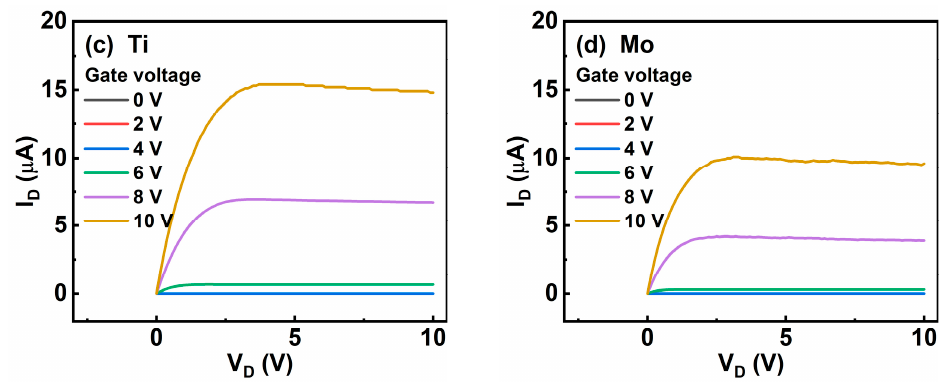
Figure 4. Output curves of annealed ITO TFTs with ( a ) Al, ( b ) ITO, ( c ) Ti, and ( d ) Mo source/drain electrodes.